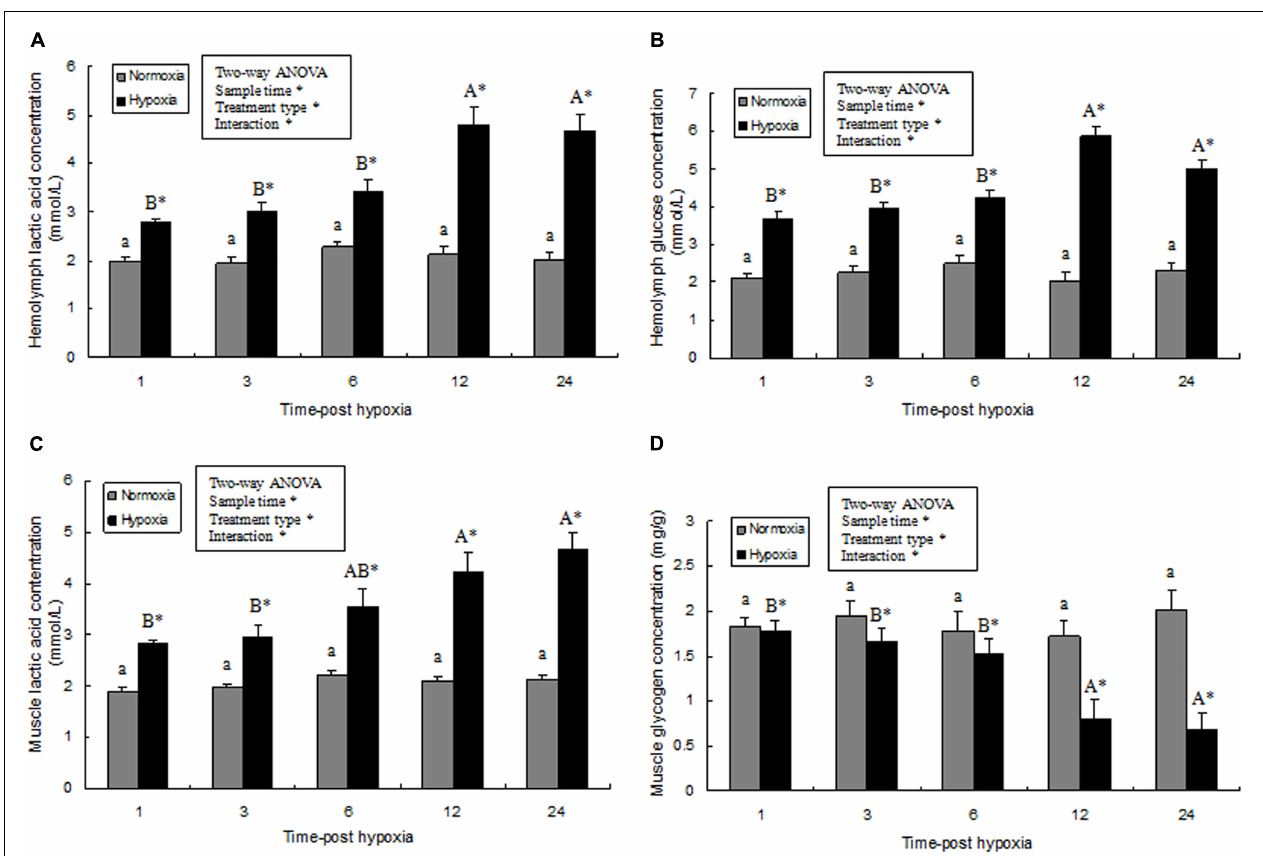
FIGURE 5 | Effects of hypoxia on hemolymph lactic acid (A) , hemolymph glucose concentration (B) , muscle lactic acid levels (C) , and muscle glycogen content (D) , respectively. Results are expressed as mean ± SE ( n = 9). Significant differences ( P < 0.05) among sampling times within each treatment are indicated by different letters (upper case for hypoxia, and lower case for mormoxia). Student’s t -test was used to compare the hypoxia and control groups. Asterisks indicate significant differences between the hypoxia group and normoxia group ( P <